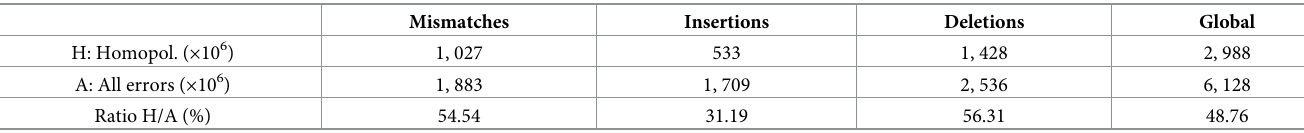
Table 4. Human: Total and homopolymer-induced sequencing errors.